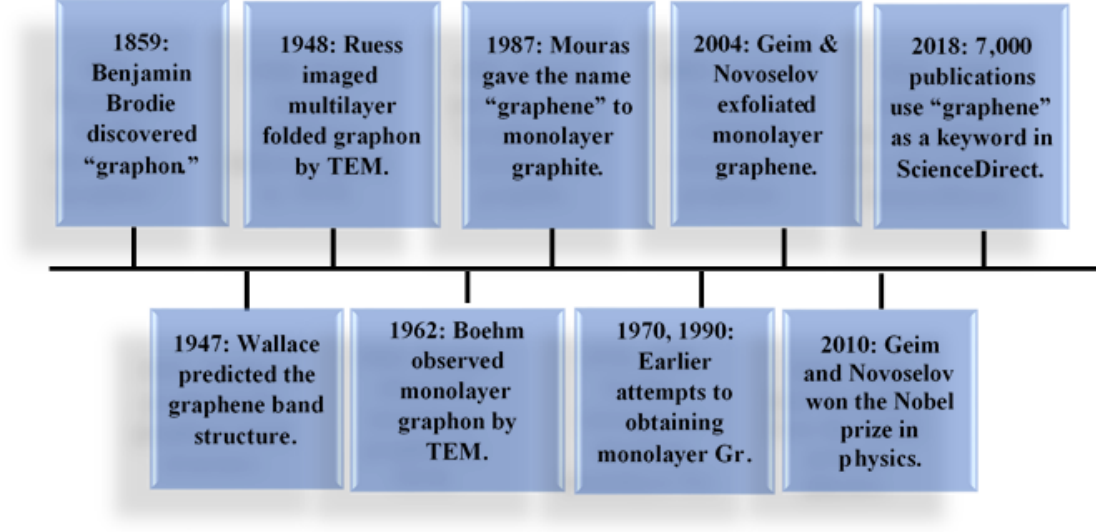
Figure 2: Timeline of the most important milestones in graphene history.